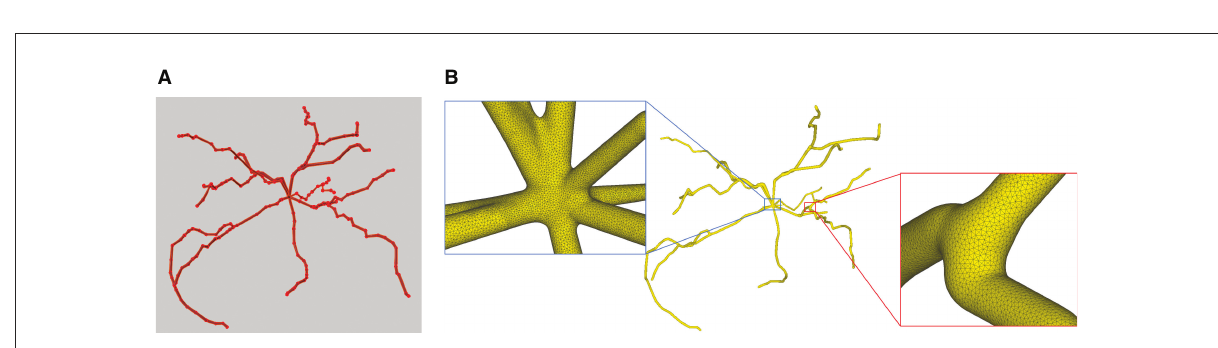
FIGURE2 A basal ganglia neuron acquired from NeuroMorpho.Org. (A) The point-and-diamter representation. (B) The generated mesh representation.